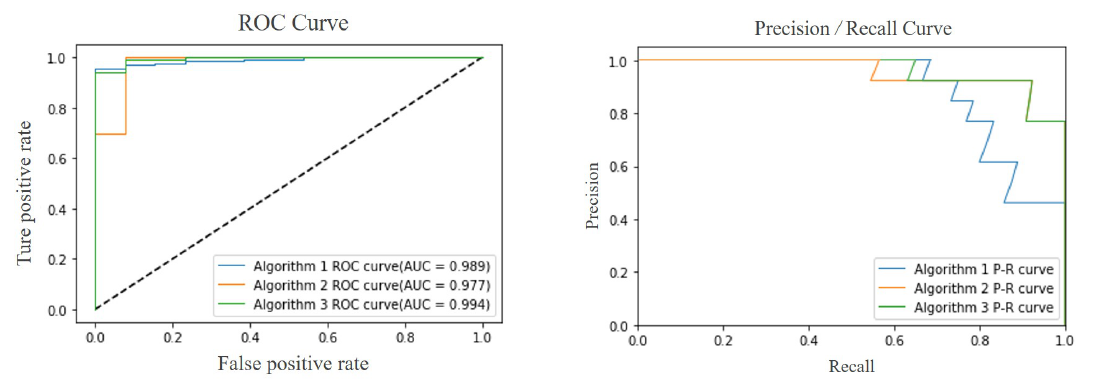
Figure 8. The curves of Receiver Operating Characteristic (ROC) and Precision–Recall (P–R) for three algorithms.